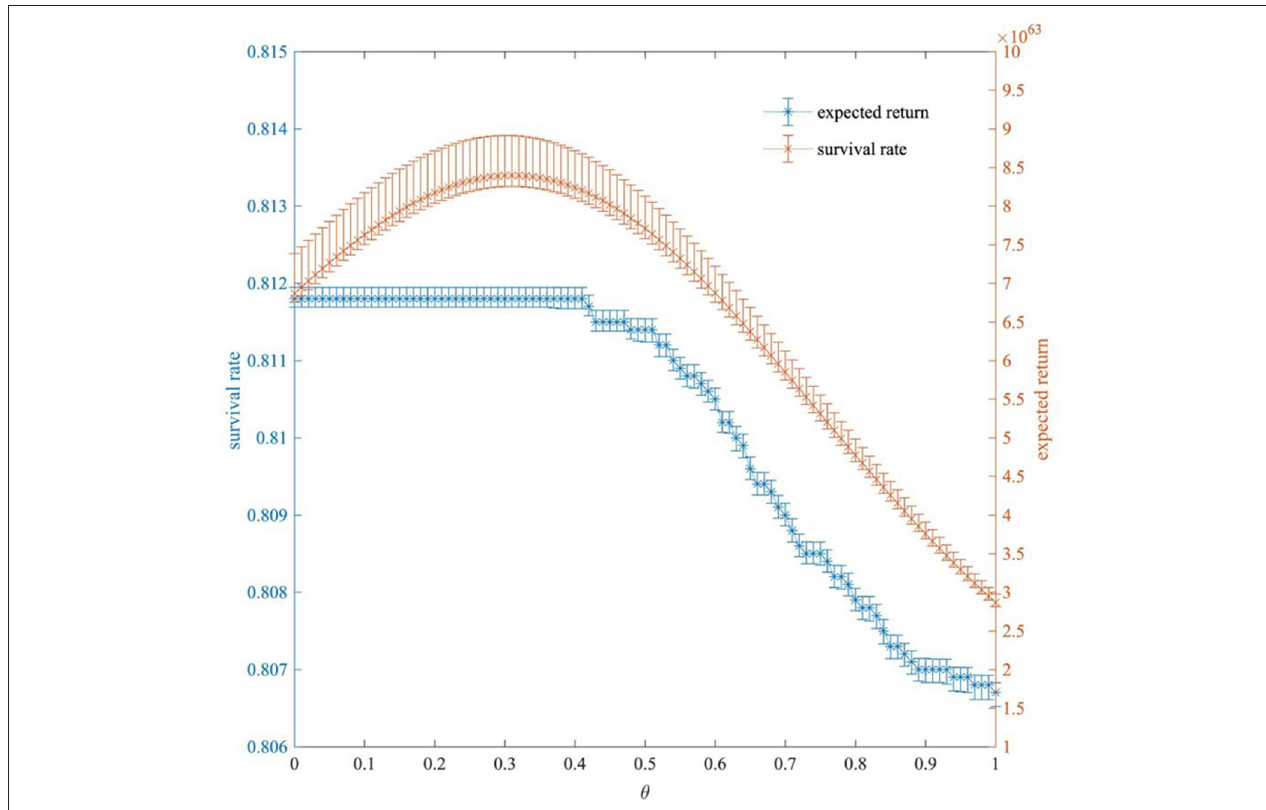
FIGURE 6 | The expected return and survival rate of the bank under different values of θ